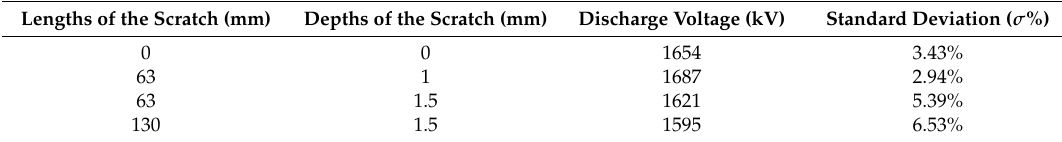
Table 2. Switching impulse voltage U 50% without burrs.